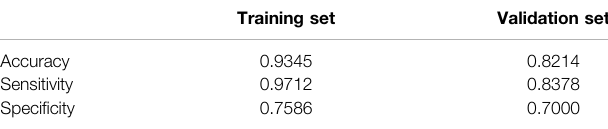
TABLE 5 | Prediction metrics of the training and validation